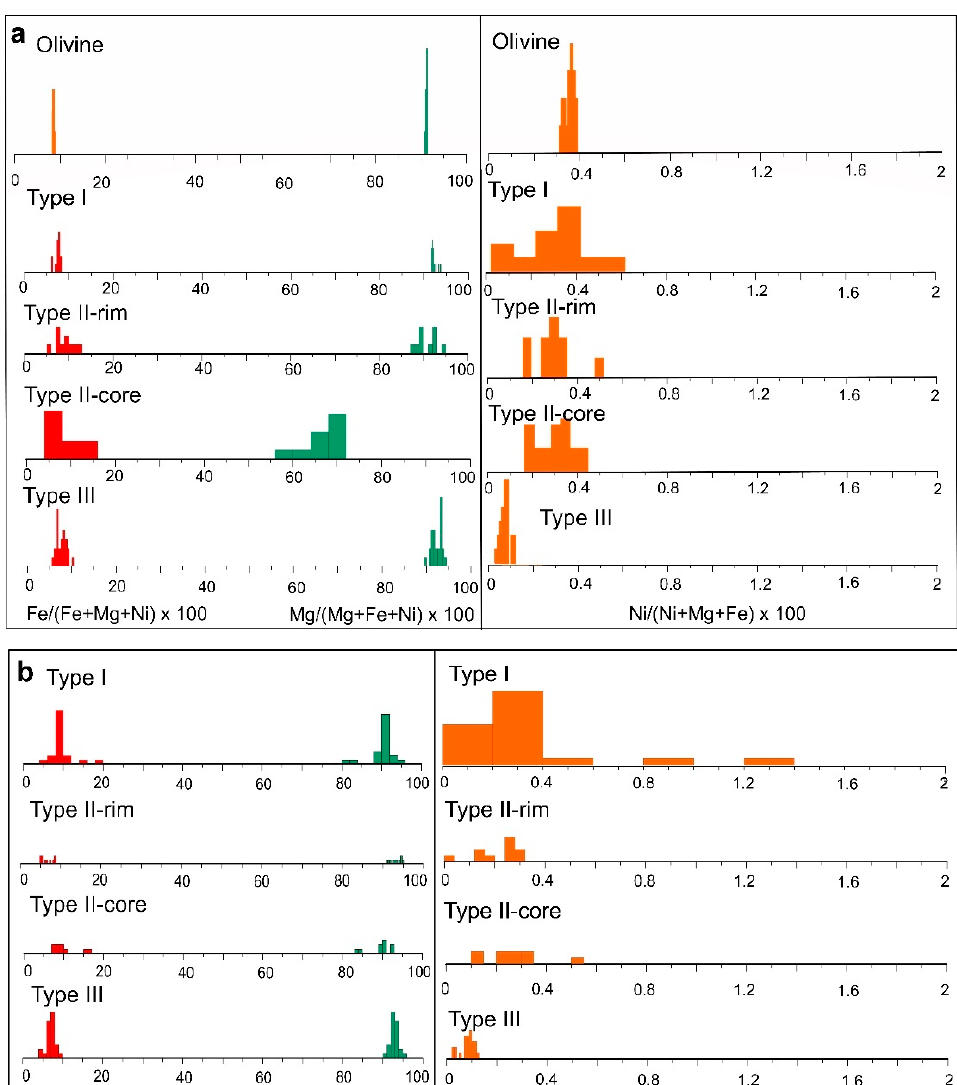
Figure 10 . Histogram of Mg (green), Fe (red) and Ni (orange) mol ratio in olivine and the different types of serpentine identified in the ( a ) lherzolite and ( b ) harzburgite-dunite bedrock.